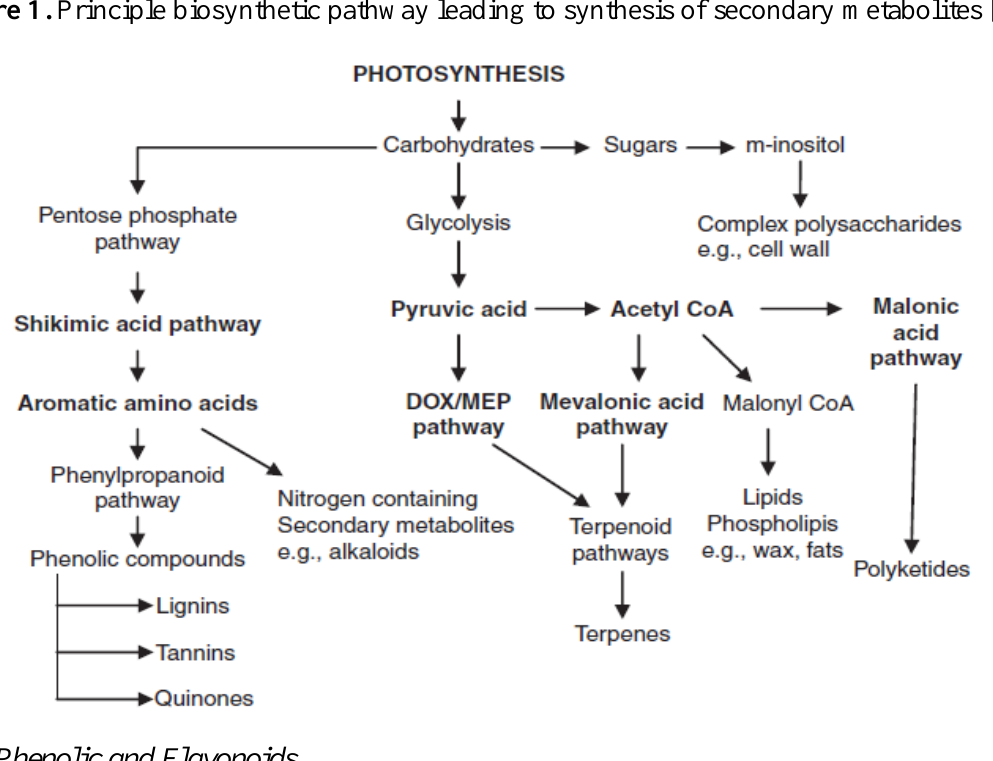
Figure 1. Principle biosynthetic pathway leading to synthesis of secondary metabolites